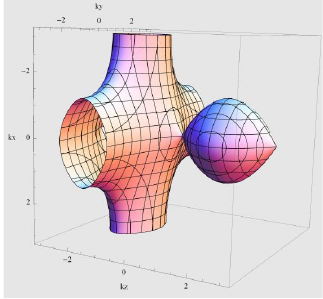
Figure 3. The typical form of the Fermi surface for a type II Weyl semimetal described by the toy model of [31]. The two Fermi pockets touch each other at the two type II Weyl points. One Fermi pocket has the topology of a sphere while another has the topology of a Riemann surface with two handles. The three axes of the figure correspond to the three components of momenta.